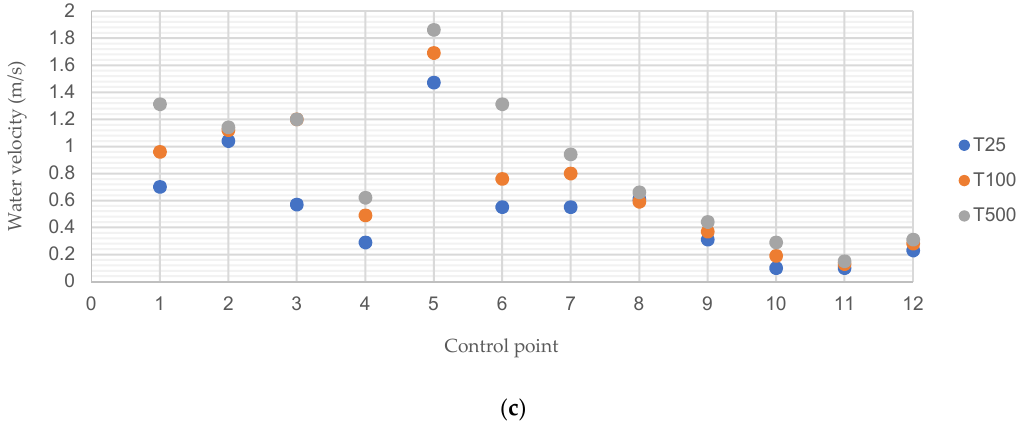
Figure 12. Flooding magnitude assessment for the different return periods considered (25, 100, and 500 years): ( a ) location of the control point selected in yellow color; ( b ) depth expected at each control point; ( c ) water velocity expected at each control point.